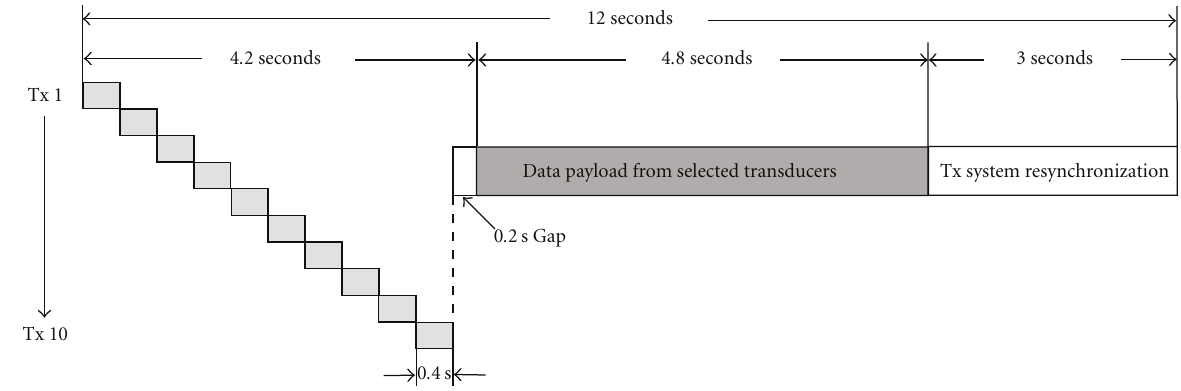
Figure 3: MIMO packet structure in Makai05 experiment.